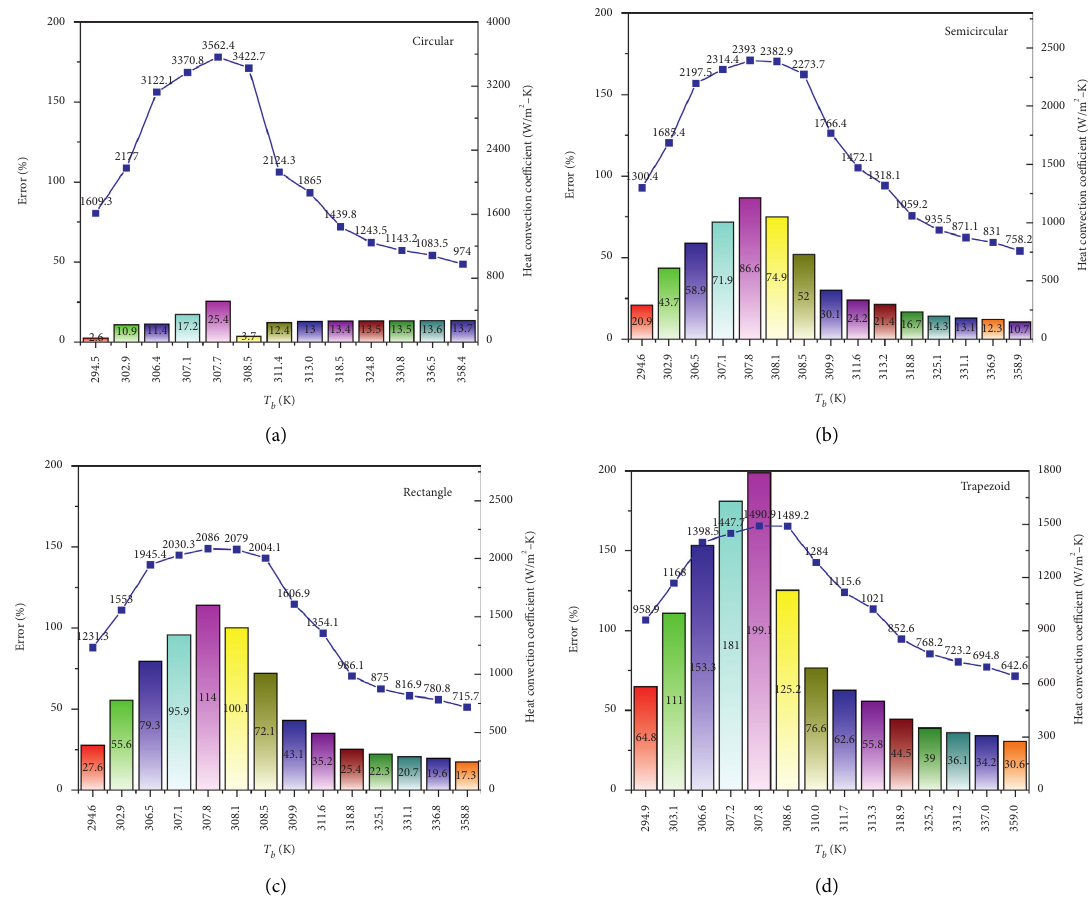
Figure 10: The relative error between CFD and Jackson correlation analysis results for the heating mode: (a) circular; (b) semicircular; (c) rectangle; and (d) trapezoid.